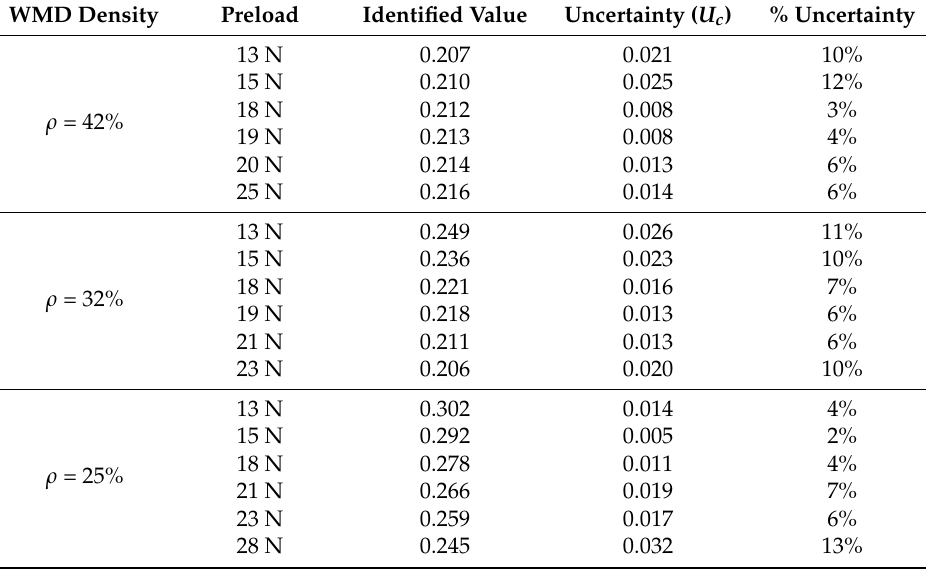
Table A3. Combined standard uncertainty of WMD loss factor ( γ ) in Figure